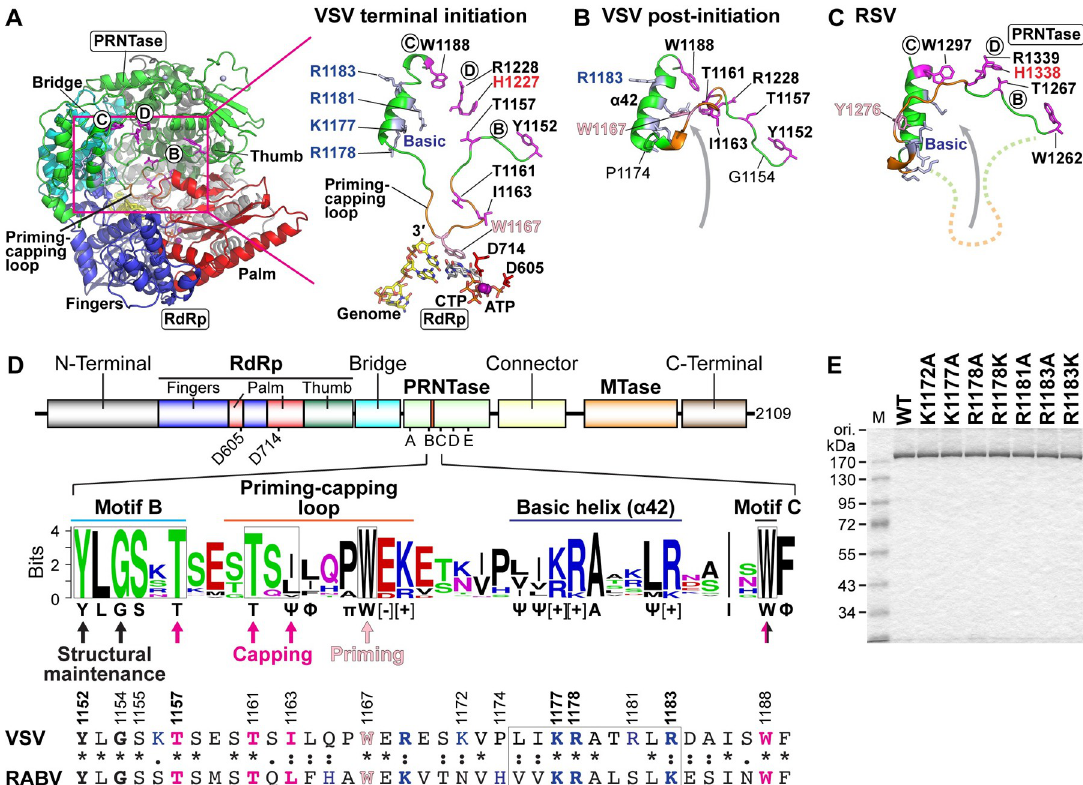
Fig 1. The priming-capping loop is anchored to a highly basic α -helix structure in the VSV PRNTase domain. ( A ) A structural model of the RdRp (fingers subdomain, blue; palm subdomain, red; thumb subdomain, dark green) and PRNTase (green) domains of the VSV L protein in a terminal initiation complex (Model Archive id: ma-5k432) is shown as a ribbon diagram (left). Key amino acid residues (T1161, I1163, W1167) on the priming-capping loop (orange) and flanking helix, active site amino acid residues in the RdRp (D605, D714) and PRNTase (Y1152 and T1157 in motif B, W1188 in motif C, H1227 and R1228 in motif D) domains, the 3 0 -terminal of the genome (3 0 -UGCU-5 0 ), and initiator (ATP) and incoming (CTP) nucleotides are shown in stick model (close-up view, right). ( B and C ) A putative post-initiation conformation of the VSV priming-capping loop ( B ) was modeled based on the structure of its HRSV counterpart ( C ) in the apo-state of the HRSV L-P RdRp complex (PDB id: 6PZK). For context in ( C ), the priming-capping loop in a putative initiation state conformation is shown in a dashed-line. ( D ) A schematic structure of the VSV L protein is shown with proposed domains/subdomain [1] (upper). MTase indicates methyltransferase. The positions of RdRp catalytic residues (D605 and D714) and PRNTase motifs (A–E) are indicated. An amino acid sequence logo for regions ranging from PRNTase motif B to motif C in L proteins of vertebrate and arthropod rhabdoviruses (excluding novirhabdoviruses) was generated by the WebLogo program (middle). Conserved amino acid residues are shown below the logo. C , F , π , [–], and [+] indicate aliphatic, hydrophobic, small, acidic, and basic amino acid residues, respectively. Amino acid residues required for the mRNA capping activity, terminal de novo initiation (priming) activity, and structural maintenance of the VSV PRNTase domain are marked by magenta, pink, and black arrows, respectively [21,29]. Local amino acid sequences of the VSV and RABV L protein are shown (lower). The numbers indicate positions of the amino acid residues of the VSV L protein. ( E ) Purified recombinant VSV L proteins with a point-mutation in the indicated basic amino acid residues (1 μ g) were analyzed alongside with the wild-type (WT) L protein by 7.5% SDS-PAGE followed by staining with One-Step Blue. The names of the point-mutants include the original amino acid (one-letter code) at the indicated position in the VSV L protein followed by the replacement amino acid. M lane shows molecular size marker. L proteins with a single-point mutation in these basic residues and flanking non-conserved